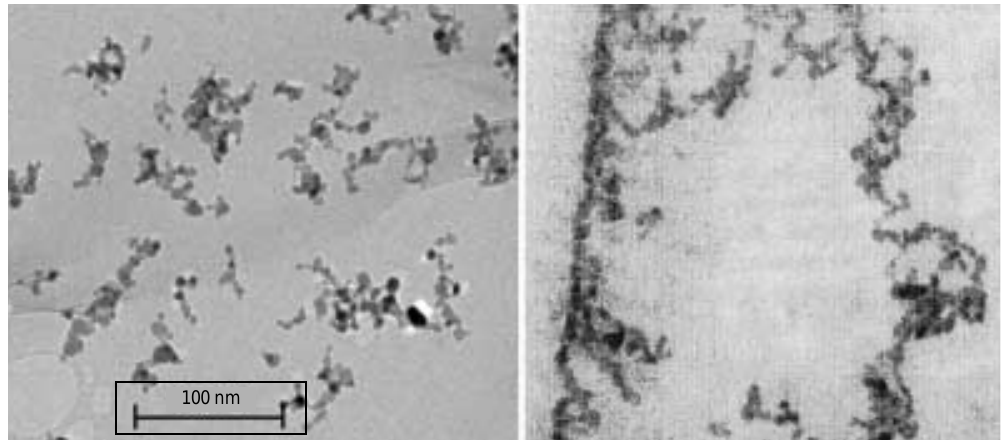
matrix).100 Fig. 18 TEM images of ITO (left: powder; right: in a polymer